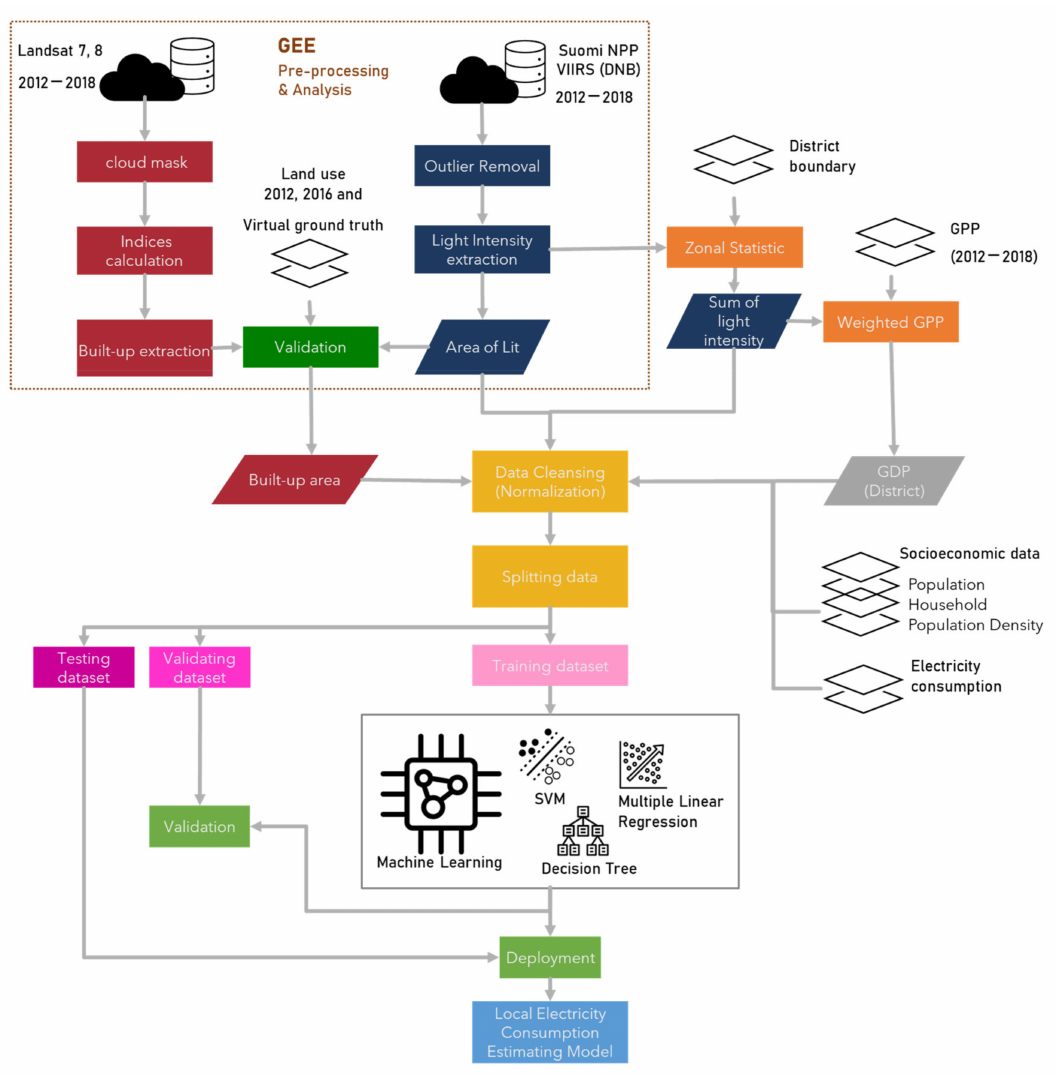
Figure 2. Flowchart of the